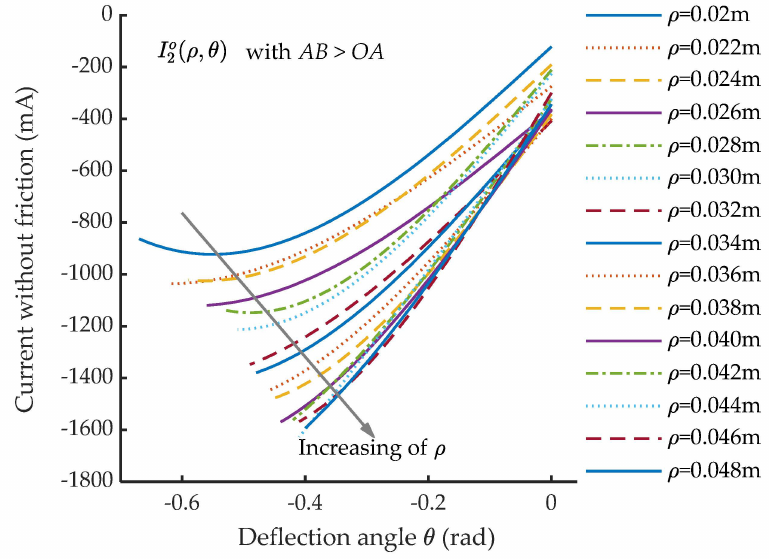
Figure 18. Frictionless current estimation for cam C 2 in configuration